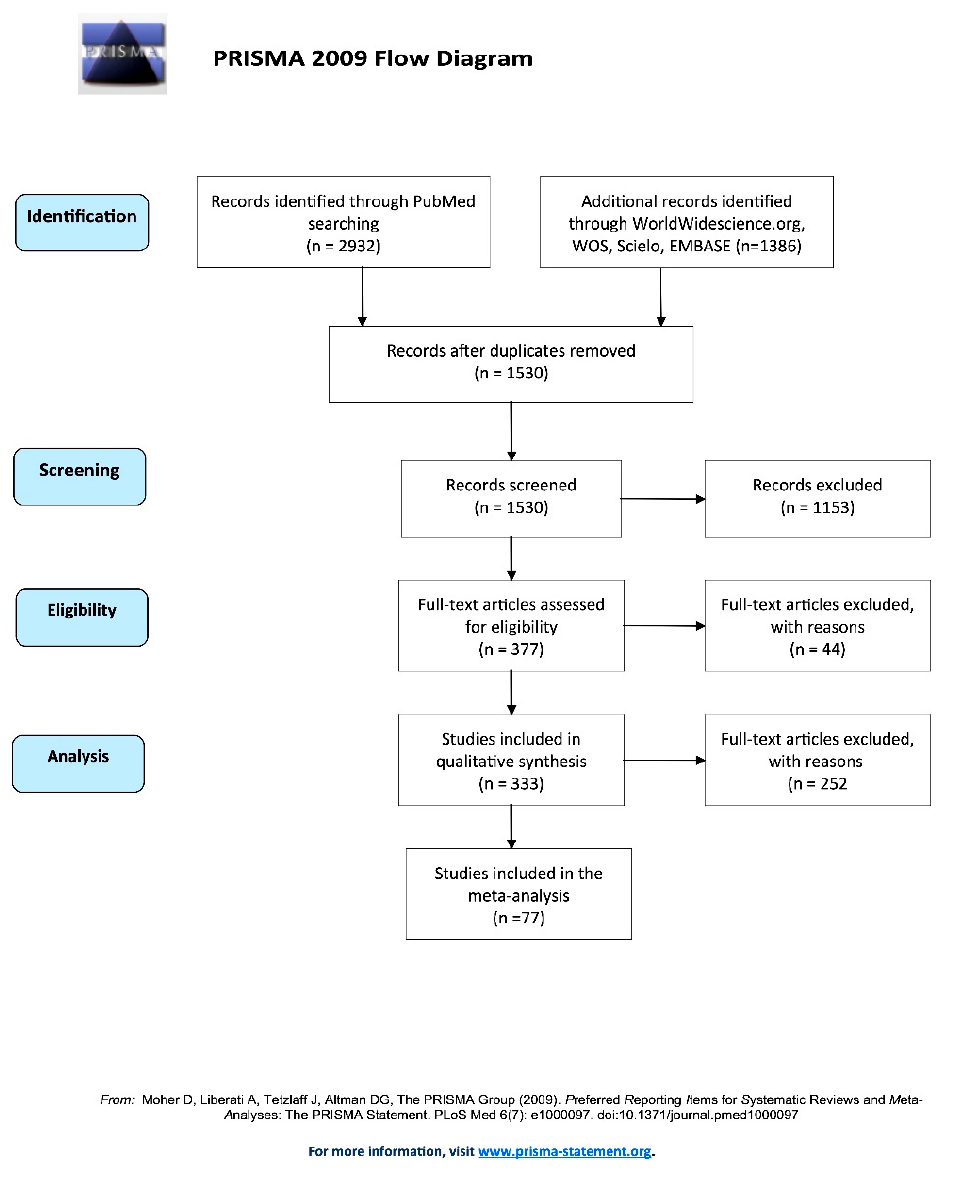
Figure 2. PRISMA flowchart of the systematic review and meta-analysis.